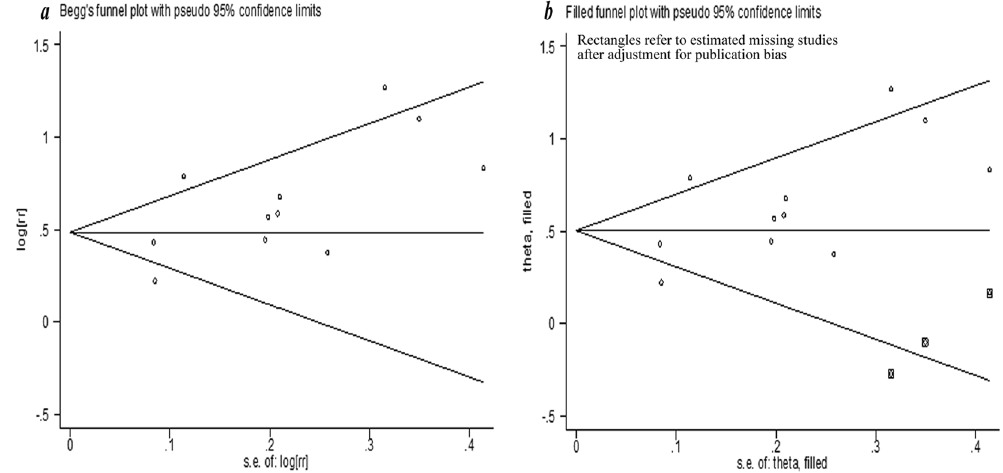
Figure 3. The funnel plot of result.